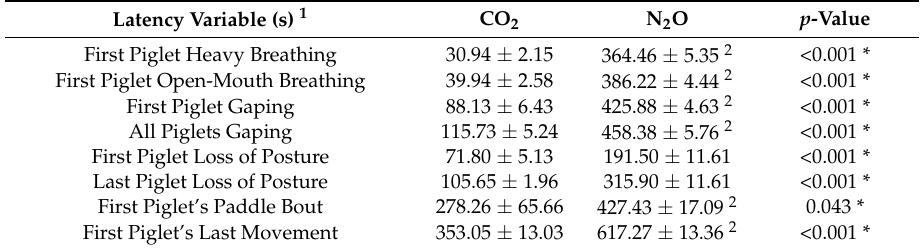
Table 6. Latency data (mean ± SE) on groups of piglets for Experiment 2.